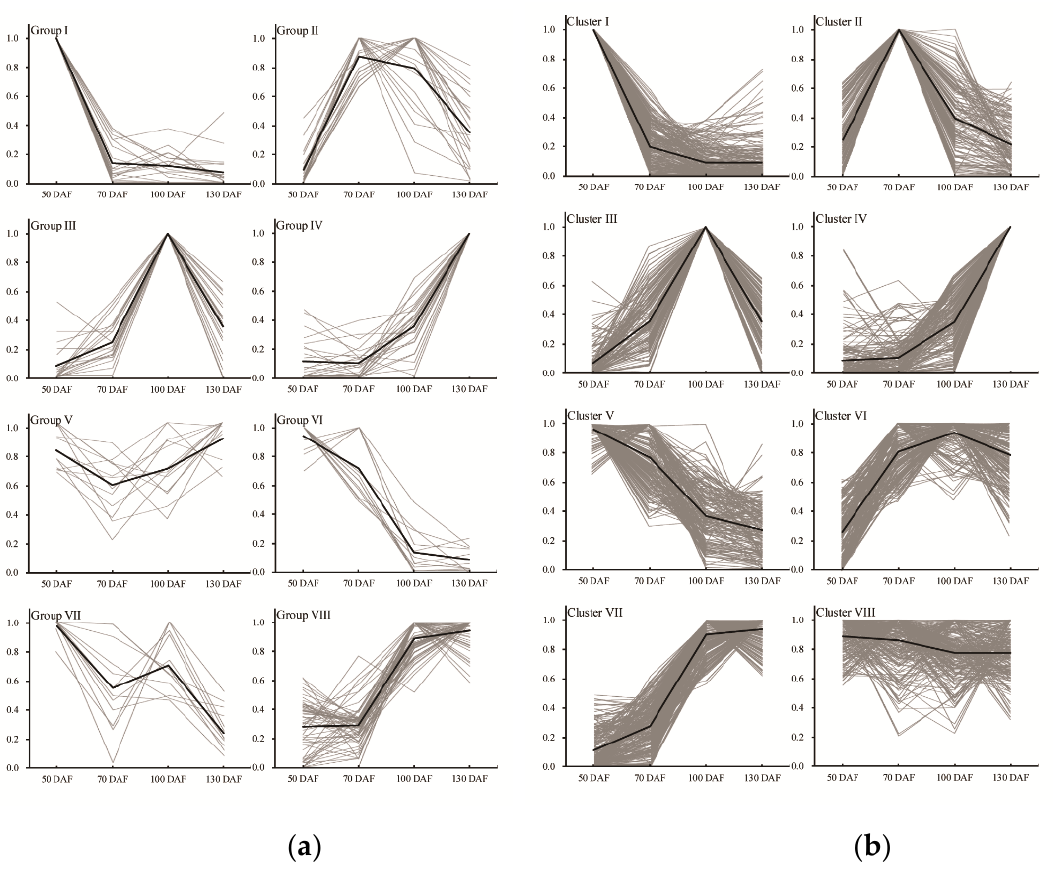
Figure 3. The K -means clustering of the metabolites during developing S. tonkinensis kernels. ( a ) The clustering results based on the metabolites of GC-MS analyses. ( b ) The clustering results based on the metabolites of LC-MS analyses.